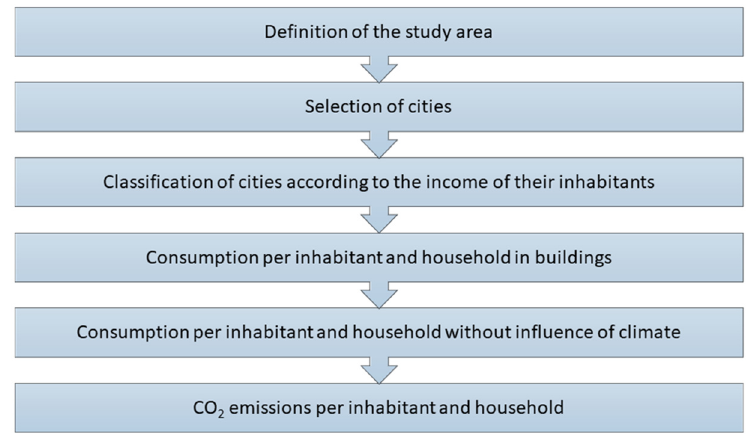
Figure 1. Methodological approach.